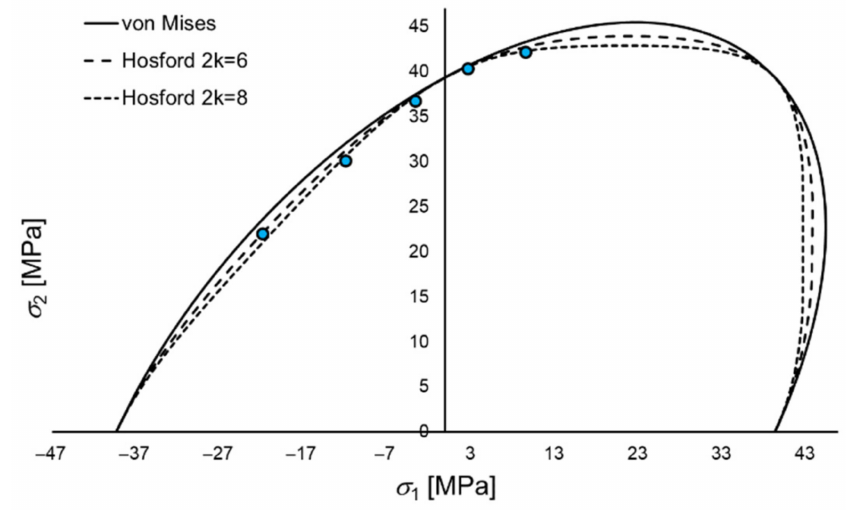
Figure 7. Resulting yield